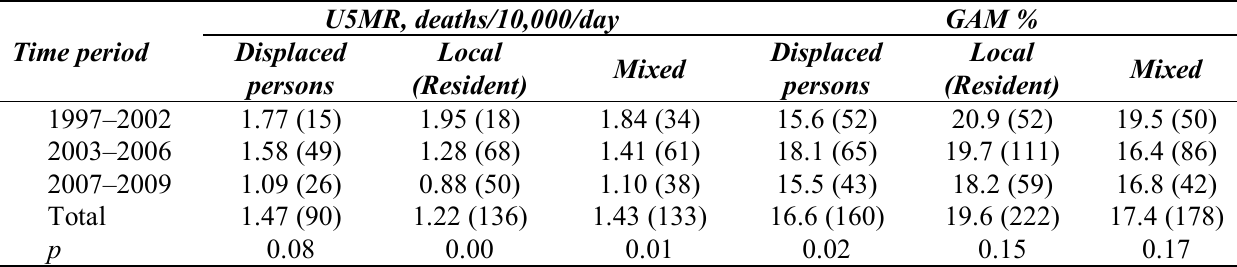
Table 3. Under-5 mortality (deaths/10,000/day) and GAM (%) by period for refugees/IDP, resident and mixed populations in pastoralists in Sudan and Kenya between 1997 and 2009 (n = number of survey results; p values estimated by Kruskall-Wallis non-parametric tests).